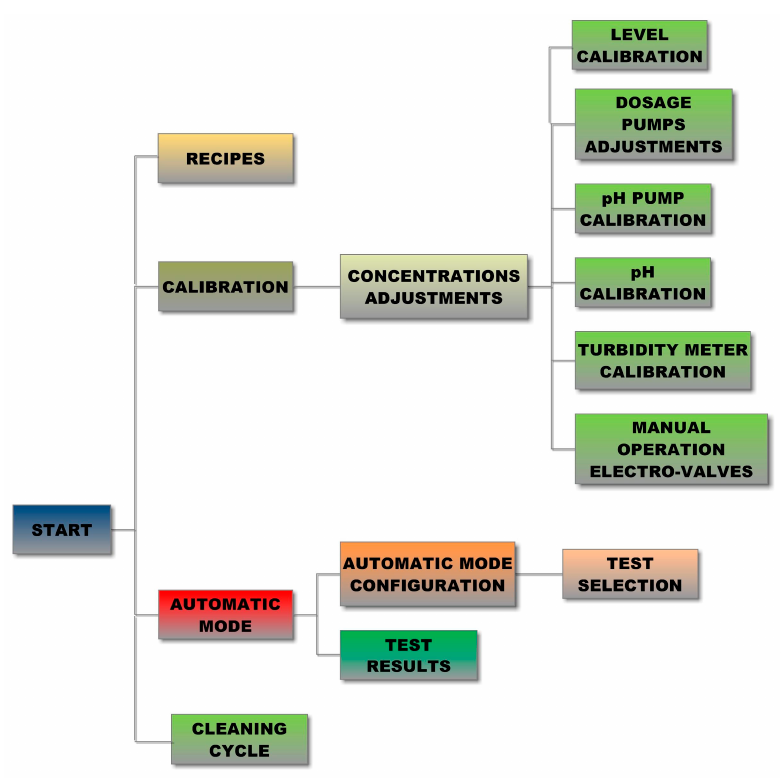
Figure 6. Navigation tree of the HMI.